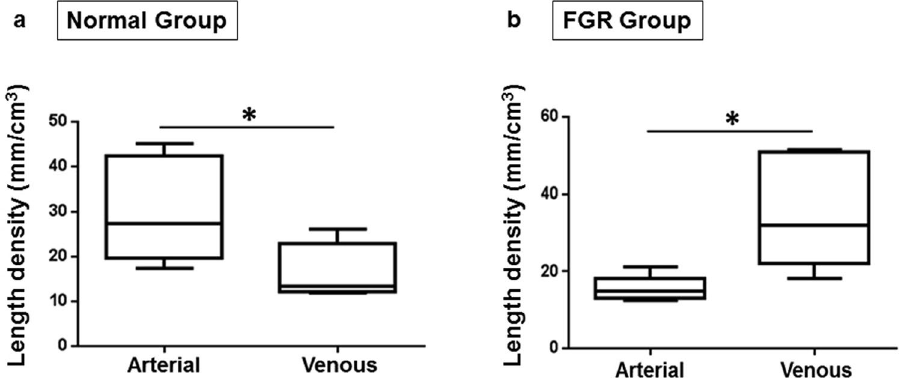
Figure 4. Arterial and venous length density in normal and FGR casts. Panels (a) and (b) represent the vessel length density in the normal and FGR casts respectively. In the normal casts, arterial paths are longer than venous paths. The opposite was observed in the FGR casts; these had longer venous paths. Data presented as boxplots showing the median, range and interquartile range. n = 12 normal (6 arterial, 6 venous) and 12 FGR (6 arterial, 6 venous) casts. Mann Whitney test, * marks two-tailed p value = 0.04 and 0.004 in a and b